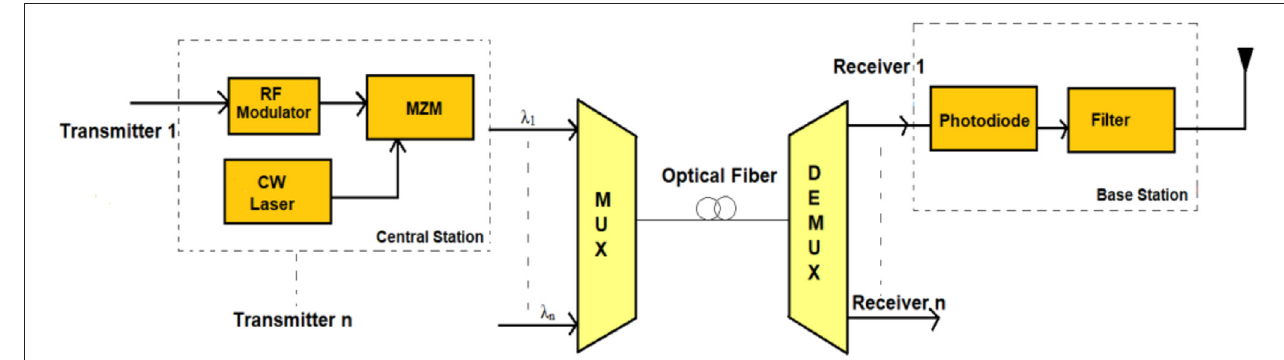
FIGURE 1 | Basic WDM-based RoF